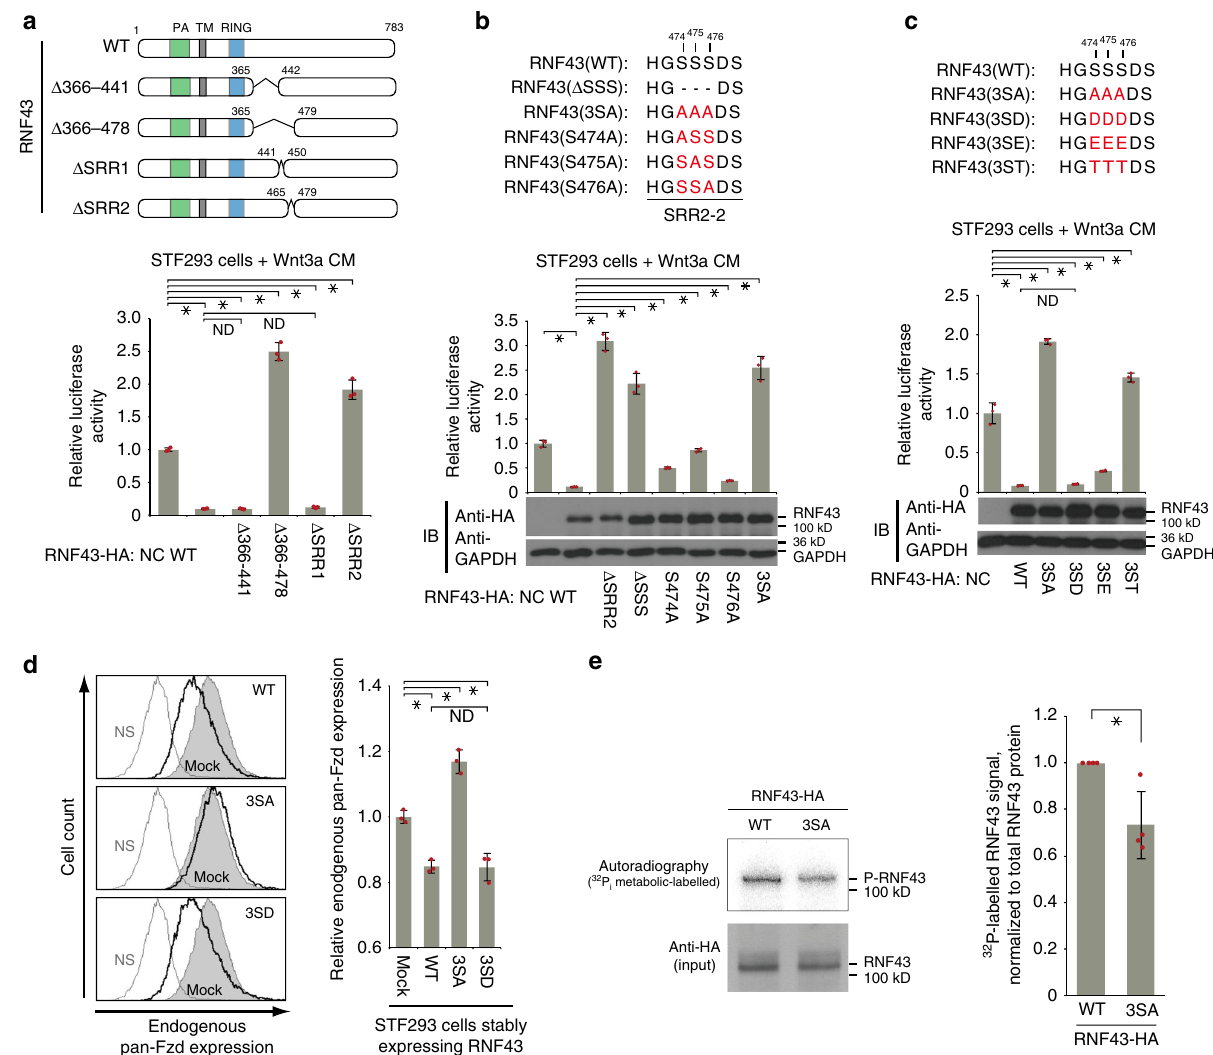
Fig. 1 RNF43 function requires phosphorylation of a serine triplet. a – c Regulation of Wnt3a-mediated activation of Wnt/ β -catenin signalling by RNF43 mutants was examined using SuperTopFlash (STF)-luciferase reporter assays. Luciferase activity in empty vector-transfected negative control (NC) cells was set to 1. SRR: serine rich region. Characters shown in red indicate amino acids after substitution ( b , c ). PA: protease-associated domain. TM: transmembrane region. RING: RING fi nger domain. d Expression of frizzled (Fzd) at the surface of RNF43 mutant-expressing cells was measured via fl ow cytometric analysis. FACS data was acquired and displayed with same strategy shown in Supplementary Fig. 1g. Grey or black lines, or grey fi lls indicate not stained, RNF43 stably expressed or mock cells, respectively. Expression in mock-transfected cells was set to 1. e Cellular phosphorylation of RNF43 was examined using 32 P i metabolic labelling. Radio-labelled RNF43 levels were normalised to total RNF43 protein levels. The relative phospho-RNF43 level in mock-transfected cells was set to 1. Bar graphs and error bars in this fi gure represent mean ± standard deviation (sd) of at least three biologically independent experiments. Red circles indicate individual values of each sample. The P values for the indicated comparisons were determined by one-way analysis of variance (ANOVA) ( P < 0.05). n = 3 ( a – d ), n = 4 ( e ) biologically independent samples. Asterisks or ND indicates signi fi cant or no signi fi cant difference in indicated comparisons,